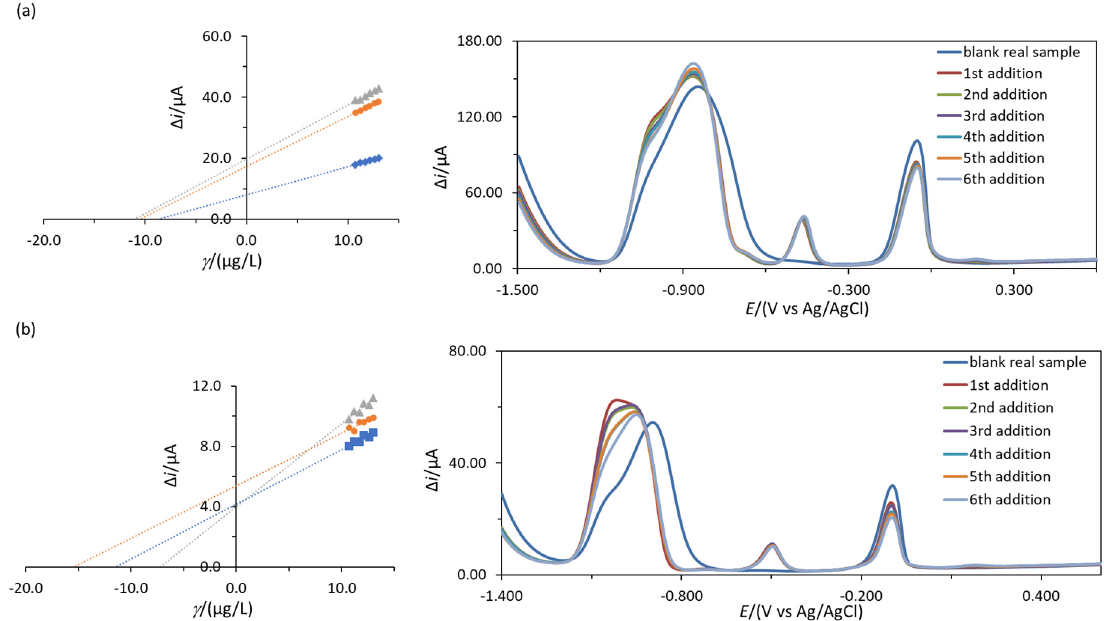
Figure 4. Real sample analysis using the multiple standard addition method (three repetitions) with Electrodes ( a ) B6 sum and ( b ) B6 prod .